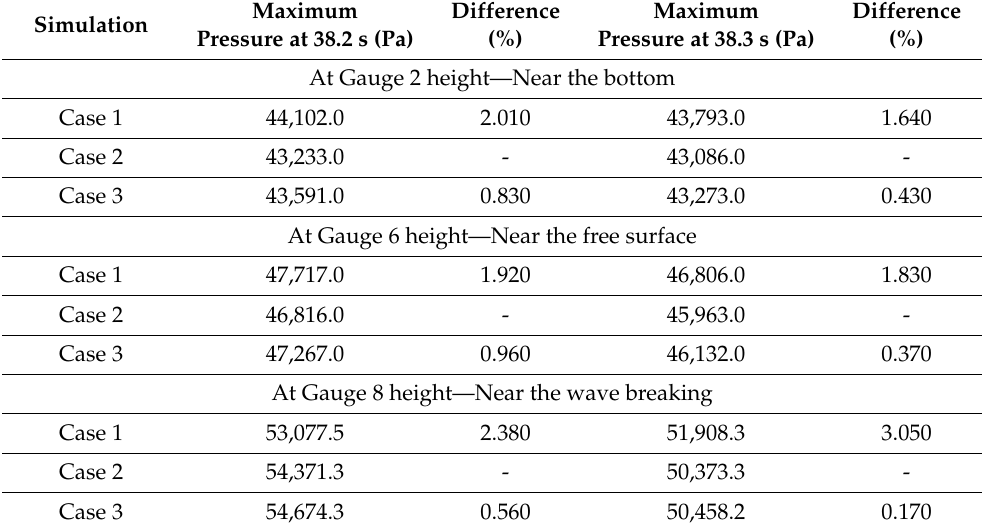
Table 12. Comparison of the pressure distribution around substructures at different